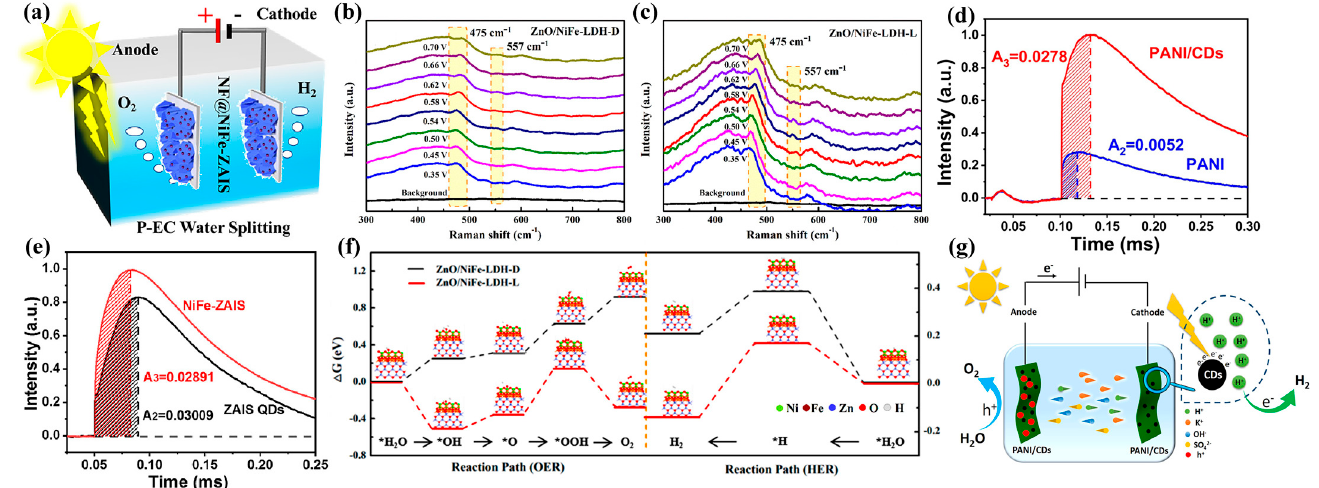
Figure 8. ( a ) Schematic illustration of NF@NiFe LDH-ZAIS QDs as a photogenerated carrier-assisted electrocatalytic water splitting electrolyzer and ( e ) charge extraction efficiency of NiFe LDH-ZAIS QDs. Adapted with permission from ref. [100]. Copyright 2021, American Chemical Society. In situ Raman spectra of ZnO/NiFe LDH ( b ) in the dark and ( c ) under light. ( f ) Reaction free energy of HER and OER under dark and light conditions. Adapted with permission from ref. [101]. Copyright 2022, Elsevier. ( d ) Charge extraction efficiency of PANI/CDs and ( g ) mechanism of PANI/CDs in P-EC overall water splitting. Adapted with permission from ref. [102]. Copyright 2021, American Chemical Society. Table 3. The main catalysts, experimental conditions, and activities of photogenerated carrier-assisted electrocatalysts for OER/HER (water splitting).